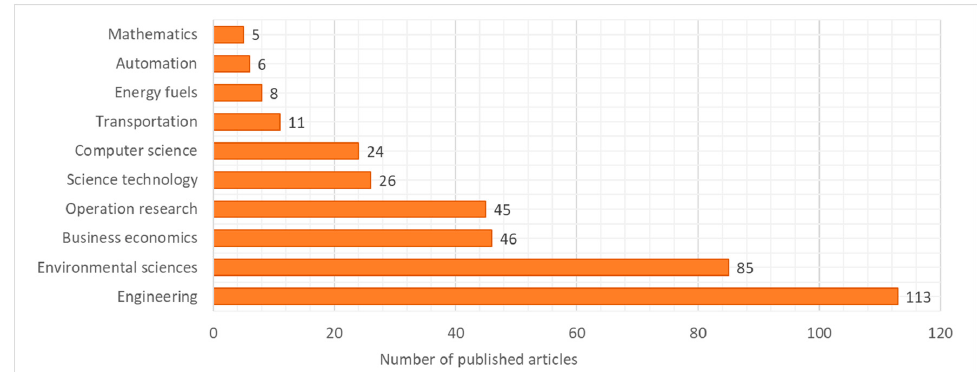
Figure 3. Classification of articles considering subject areas based on search in Web of Science database using TOPIC: “waste” AND “logistics” AND “collection”.